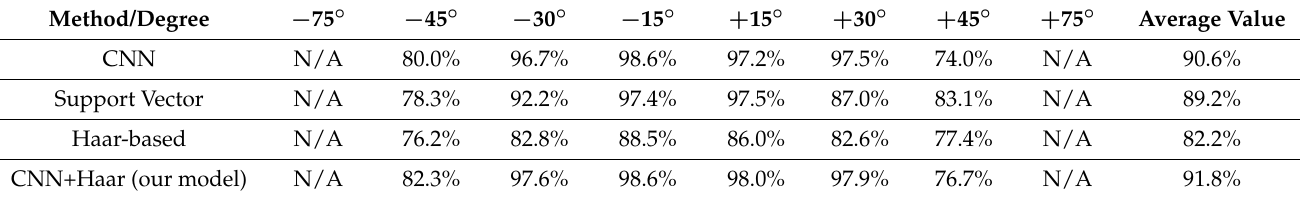
Table 4. Face detection results at different